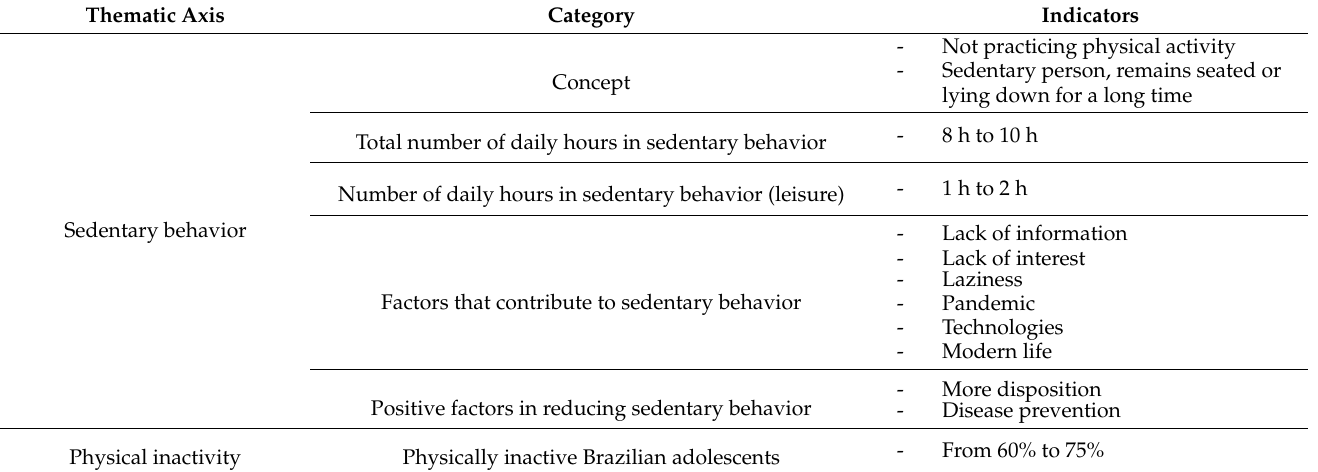
Table 6. Thematic analysis of the participants: